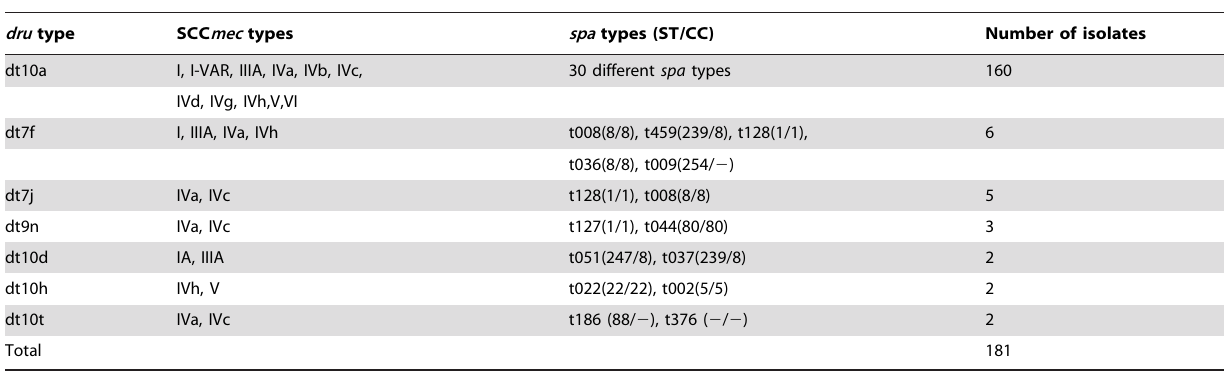
Table 3. dru types present in more than one SCC mec type a